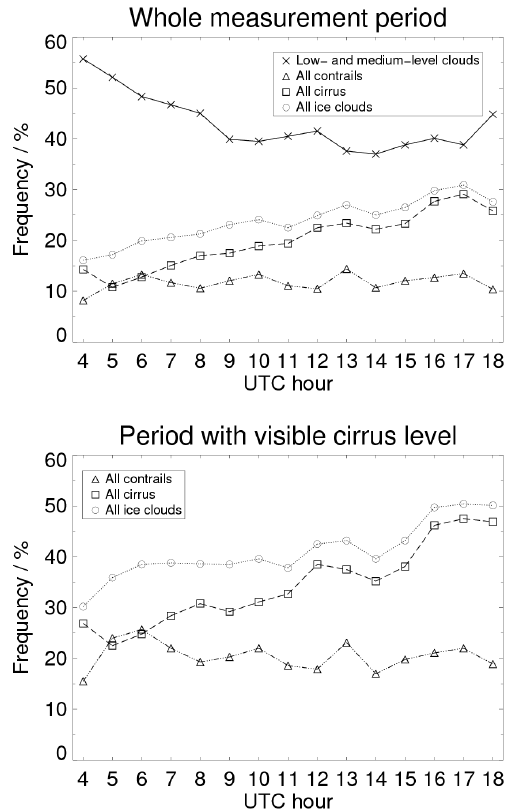
Fig. 4. Diurnal cycles of cloud classes obtained from the visual classification of ground based images. Top: Frequency of occur- rence of the categories “Low- and medium-level clouds” ( × ), “All contrails” ( 4 ), “All cirrus” ( (cid:3) ) and “All ice clouds” ( ◦ ), w.r.t. the full measurement period. Bottom: Frequency of occurrence of the categories “All contrails” ( 4 ), “All cirrus” ( (cid:3) ) and “All ice clouds” ( ◦ ), w.r.t. the time when the cirrus level was visible from the